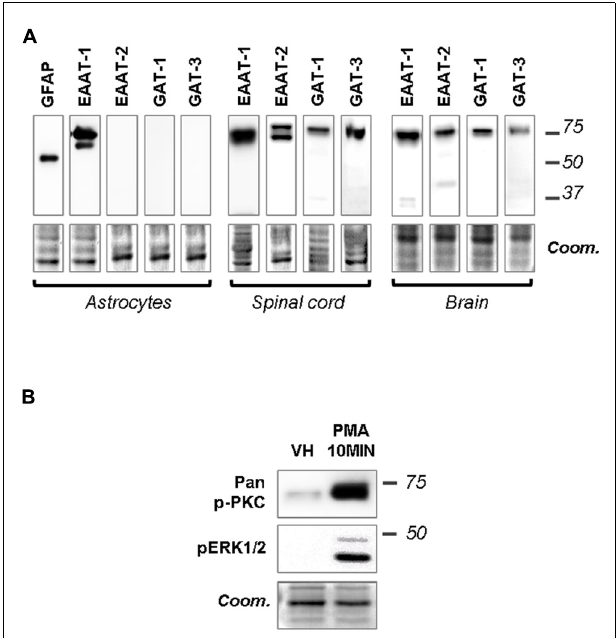
FIGURE 1 | Primary astrocytes express EAAT-1 and respond to PMA. (A) Western-blots showing that EAAT-1 is detected in cultured astrocytes, as opposed to EAAT-2 or GABA transporters GAT-1 and GAT-3. Coomassie stain (coom) is shown in the lower panels as a loading control (similar images reflect multiple incubations of the same membranes with different antibodies). Signals obtained from dorsal spinal cord and brain are also shown as positive controls. Molecular weights (kDa) are given on the right. (B) Western-blot verifying the capacity of PMA (1 μ M, 10 min) to activate the PKC pathway (pan-phospho PKC, upper panel) and downstream cascades (phospho